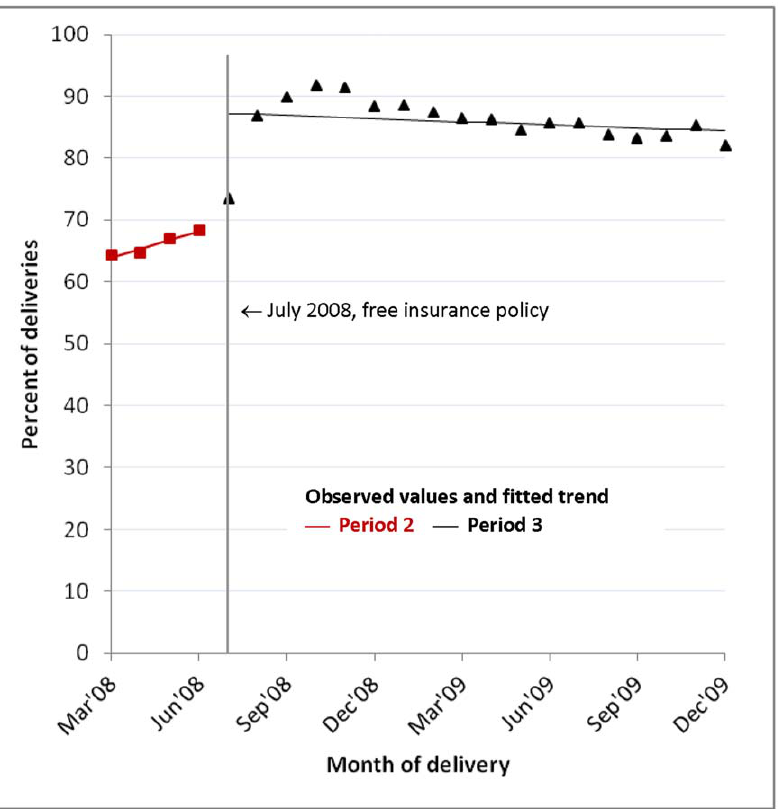
Figure 4. Insurance coverage, March 2008–December 2009: observed values and fitted trend. Figure shows the percentage of women with health insurance each month in each policy period: observed values (dots), fitted trend (straight